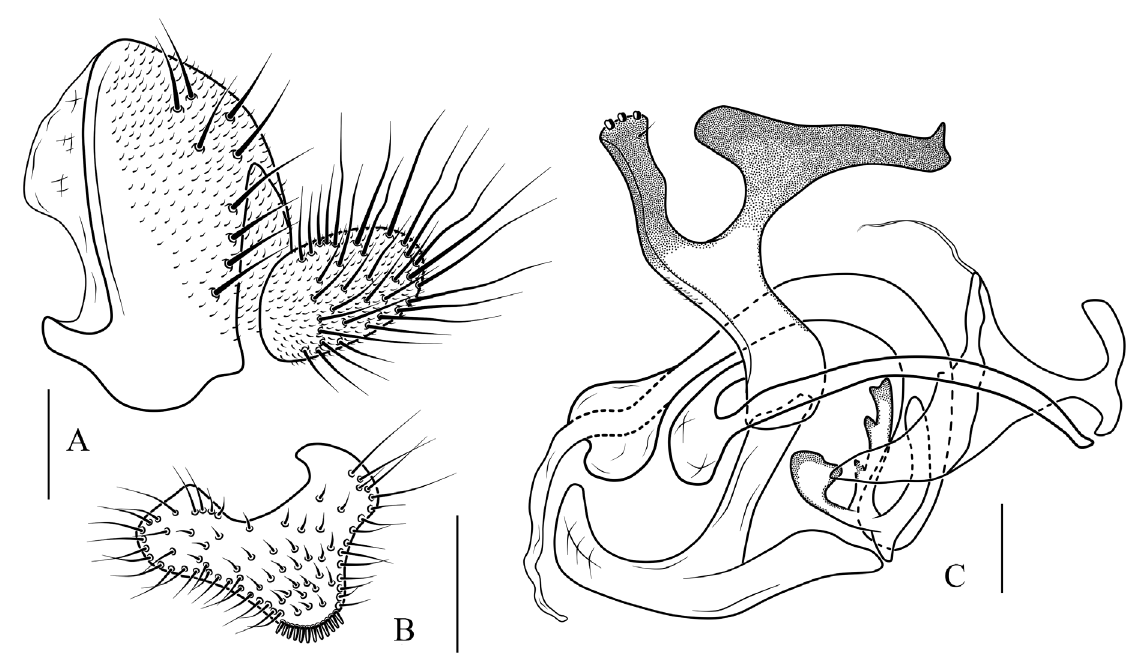
Fig. 4. Phortica ( Phortica ) mengda sp. nov., ♂. A . Epandrium and cercus. B . Surstylus. C . Hypandrium, paramere, aedeagus and aedeagal apodeme. Scale bars = 0.1